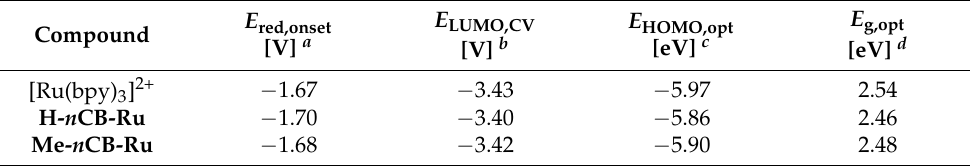
Table 3. Electrochemical properties for the ruthenium complexes. Compound